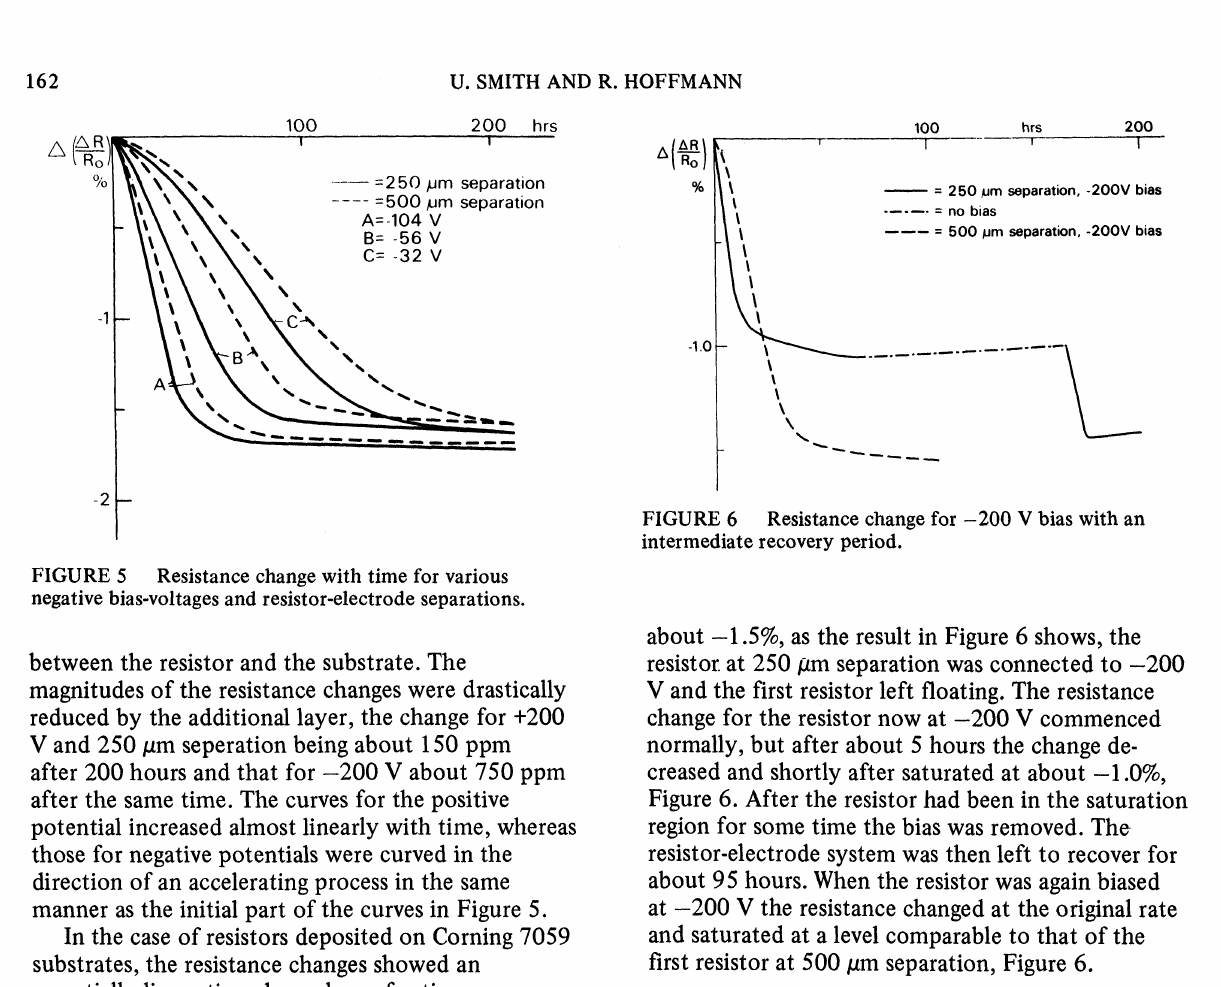
Resistance change with time for various negative bias-voltages and resistor-electrode separations.